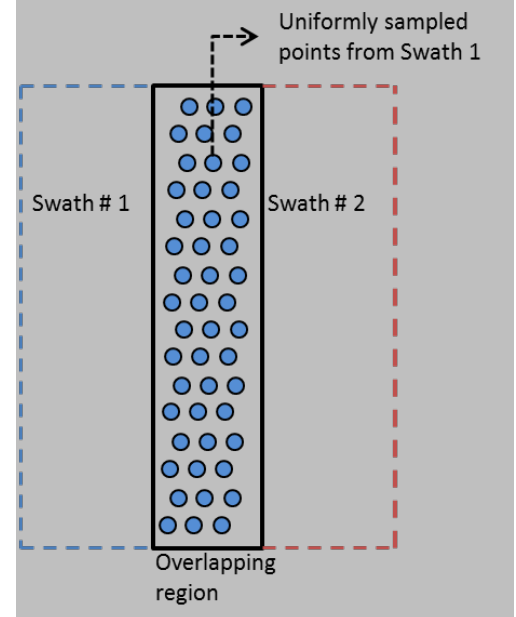
Figure 4 Implementation of prototype software for DQM